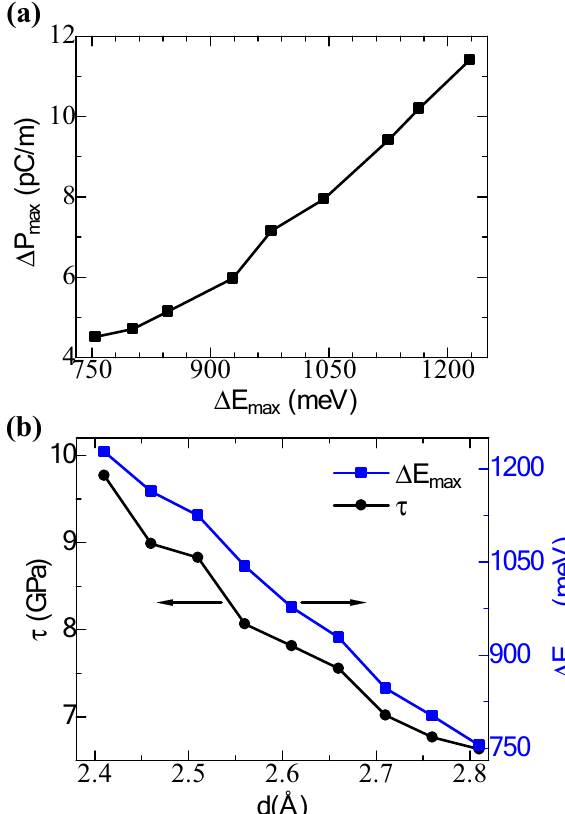
Figure 3. ( a ) The maximum polarization changes (pC/m) with the maximum sliding energy barriers (meV). ( b ) The variation of the interlayer shear strength (black line with filled circles) and maximum sliding energy barriers (blue line with blocks) with change in the interlayer distance of the InN